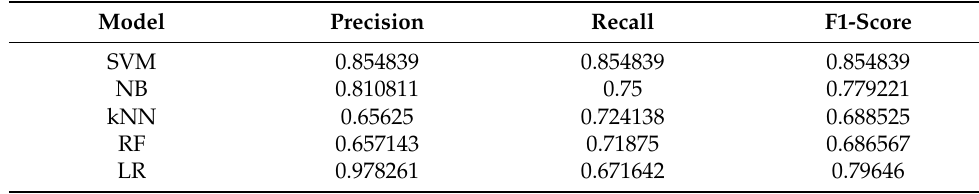
Figure 4. Accuracy comparison of ML models in all three methods. Table 6. Performance of ML models (mean